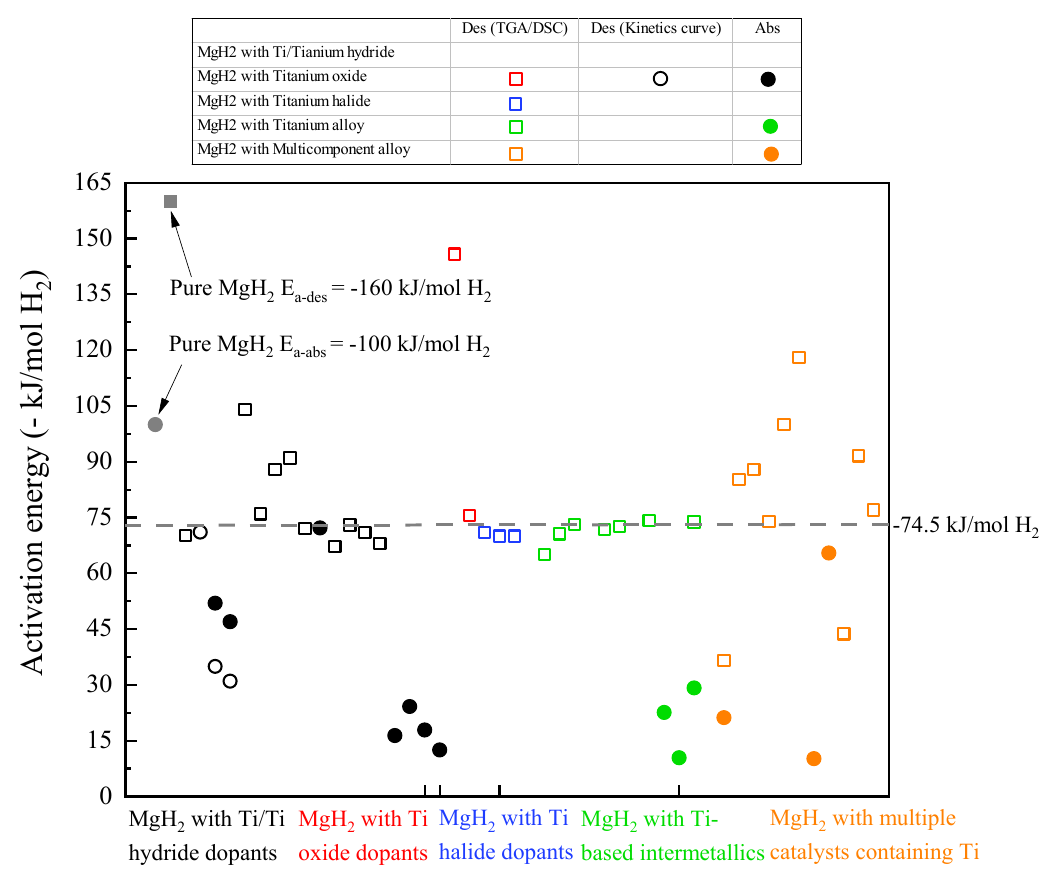
Figure 13. Apparent activation energies derived from experiments of kinetic rates for the hydrogenation and dehydrogenation in MgH 2 with the addition of various Ti-based catalysts.